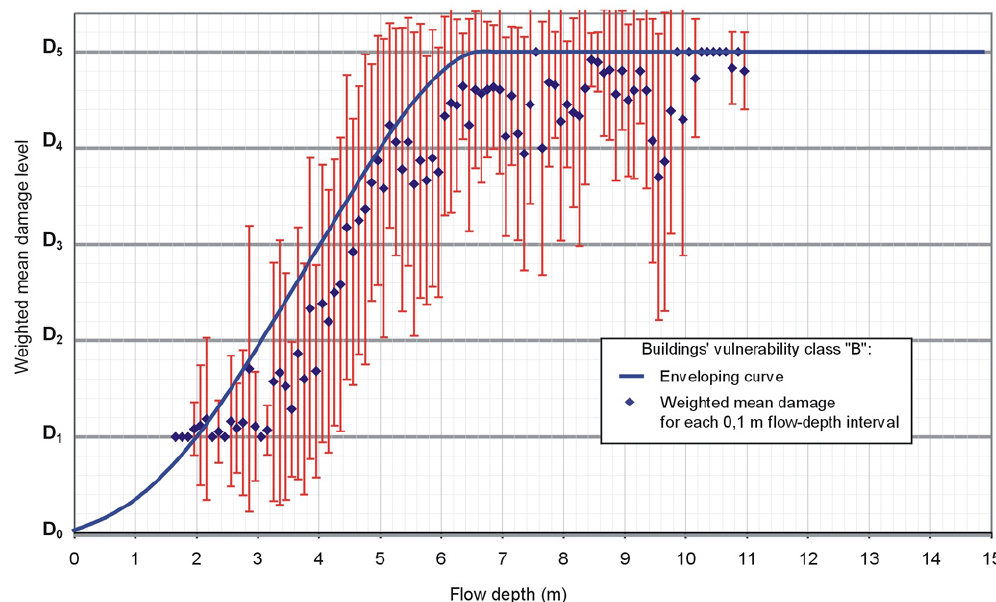
Fig. 5. Developed damage curve for class B (brick not-reinforced) buildings (Valencia et al., 2011). Error bars (in red) correspond to the dispersion around the mean damage for each water level, weighted on the total number of “B” buildings touched by the water